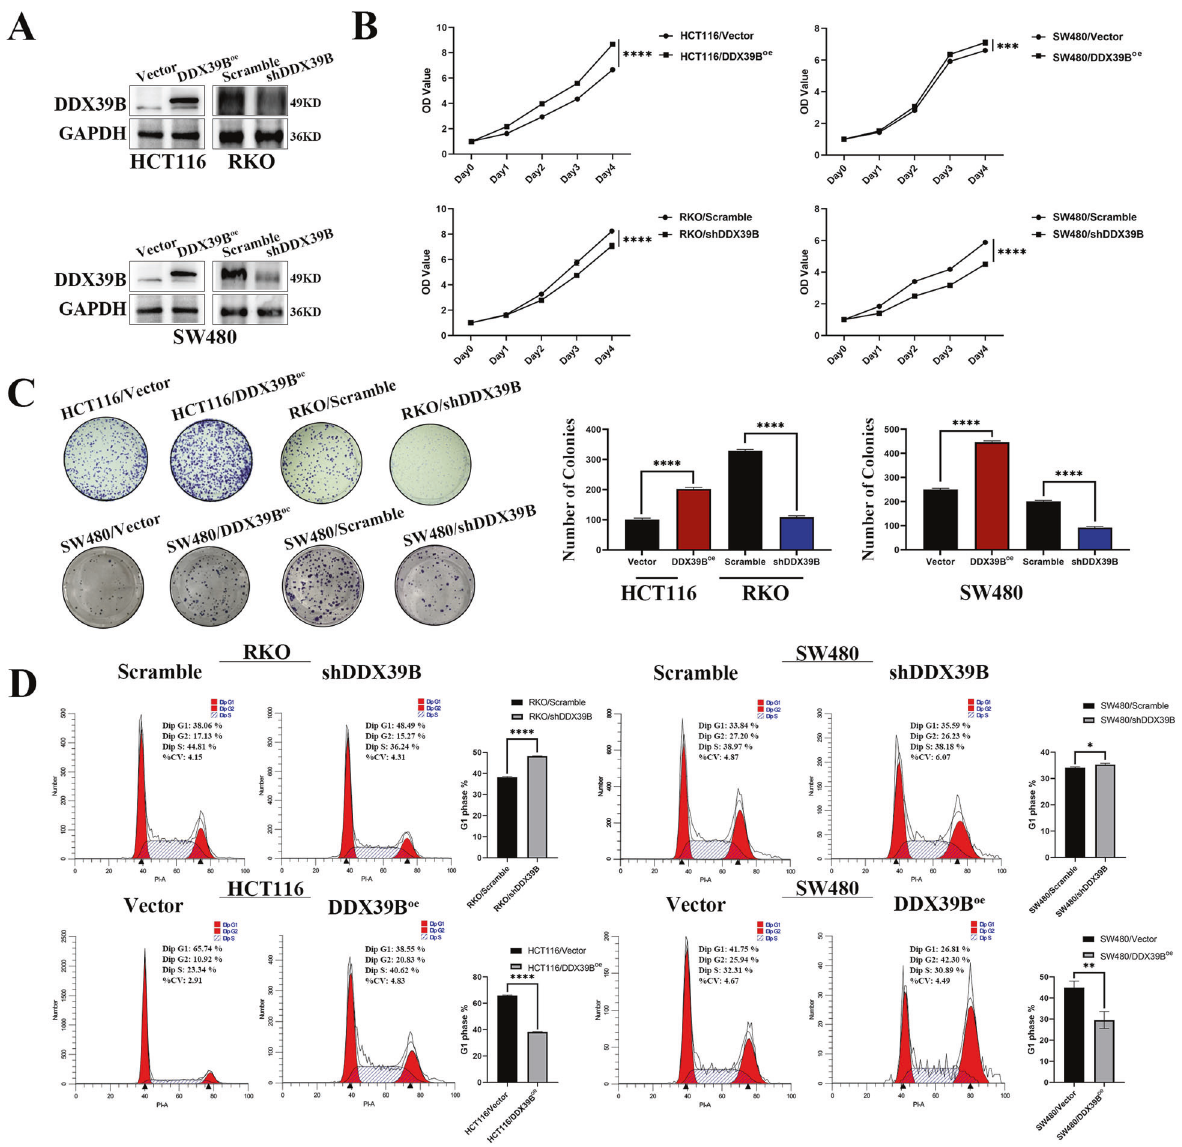
Fig. 2 DDX39B promotes the proliferation of colorectal cancer in vitro. A Transfected ef fi ciency was determined using western blotting in HCT116, SW480, and RKO cells with overexpressed or silenced DDX39B. B CCK8 assay was used for exploring the effect of overexpression of DDX39B on the proliferation of colorectal cancer in HCT116, SW480 cell lines; and the effect of inhibition of DDX39B in SW480, RKO cell lines (one-sample t -test). C Colony-forming assay was used for detecting the effect of overexpression and inhibition of DDX39B on the proliferation of colorectal cancer in HCT116, SW480 and RKO cell lines, 6-well plate, 1000 cells per well. The number of colonies were calculated in the form of a bar chart, by (one-sample t -test) pairwise. D Flow cytometry was used to detect the cell cycle of RKO/Scramble, RKO/shDDX39B; SW480/ Scramble, SW480/shDDX39B; HCT116/Vector, HCT116/DDX39B oe ; SW480/Vector, SW480/DDX39B oe groups with PI staining. Bar graph were used to show the G1 phase of cell cycle (one-sample t -test). The experiments were performed in three